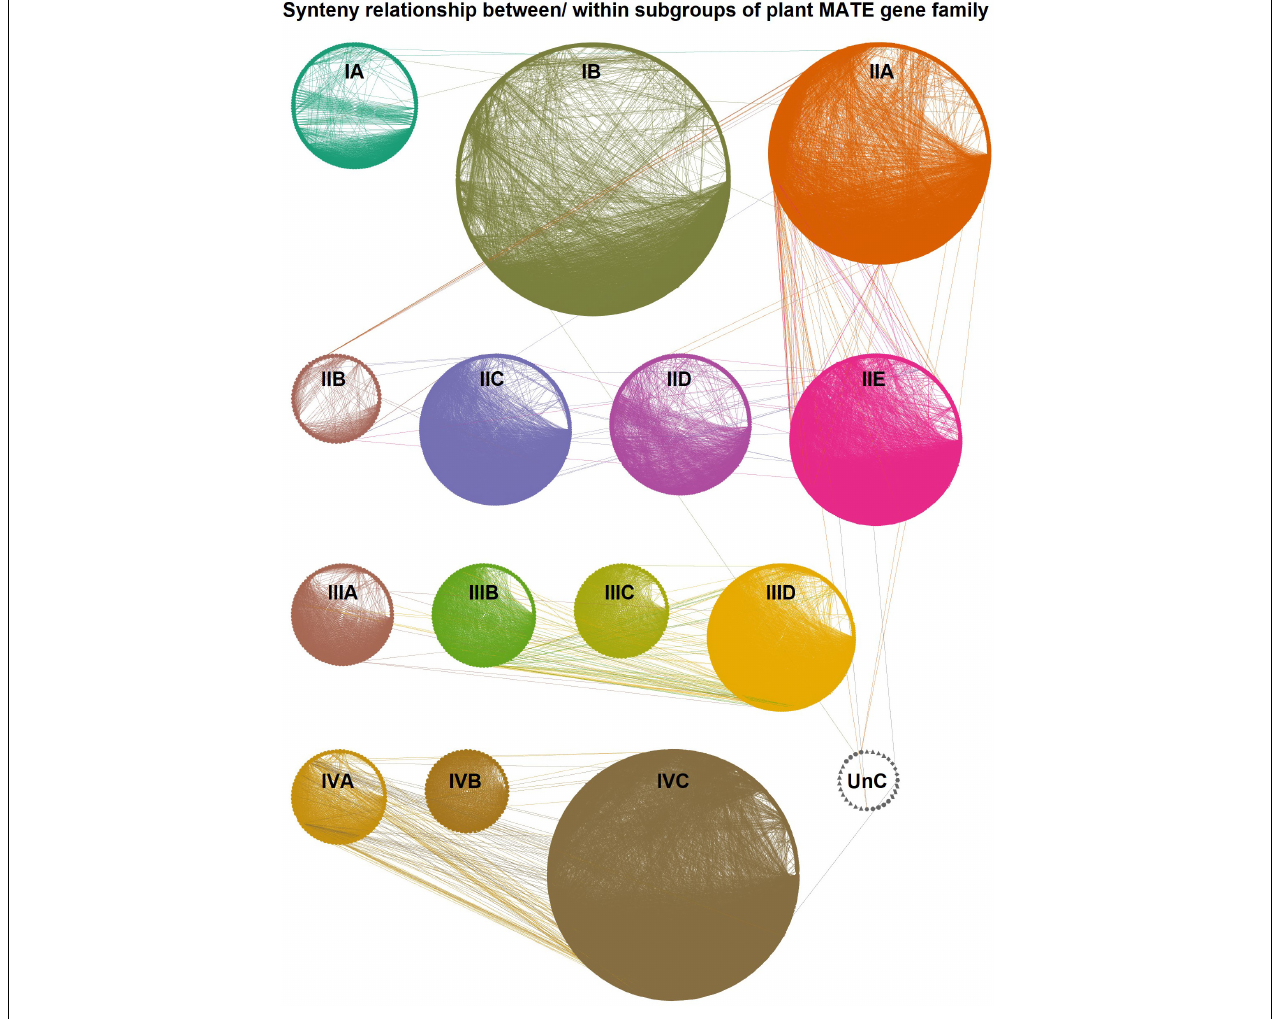
FIGURE 4 | Global synteny network (SynNet) of the plant multidrug and toxic compound extrusion (MATE) transporter gene family. The network was established with all the SynNet relations of plant MATEs within and between genomes that included 3,124 nodes having 55,276 edges and 202 communities. The network was visualized in Cytoscape and the nodes are grouped based on their subgroup. Lines connecting the nodes denote pairwise synteny relationships. Subgroups are highlighted in different